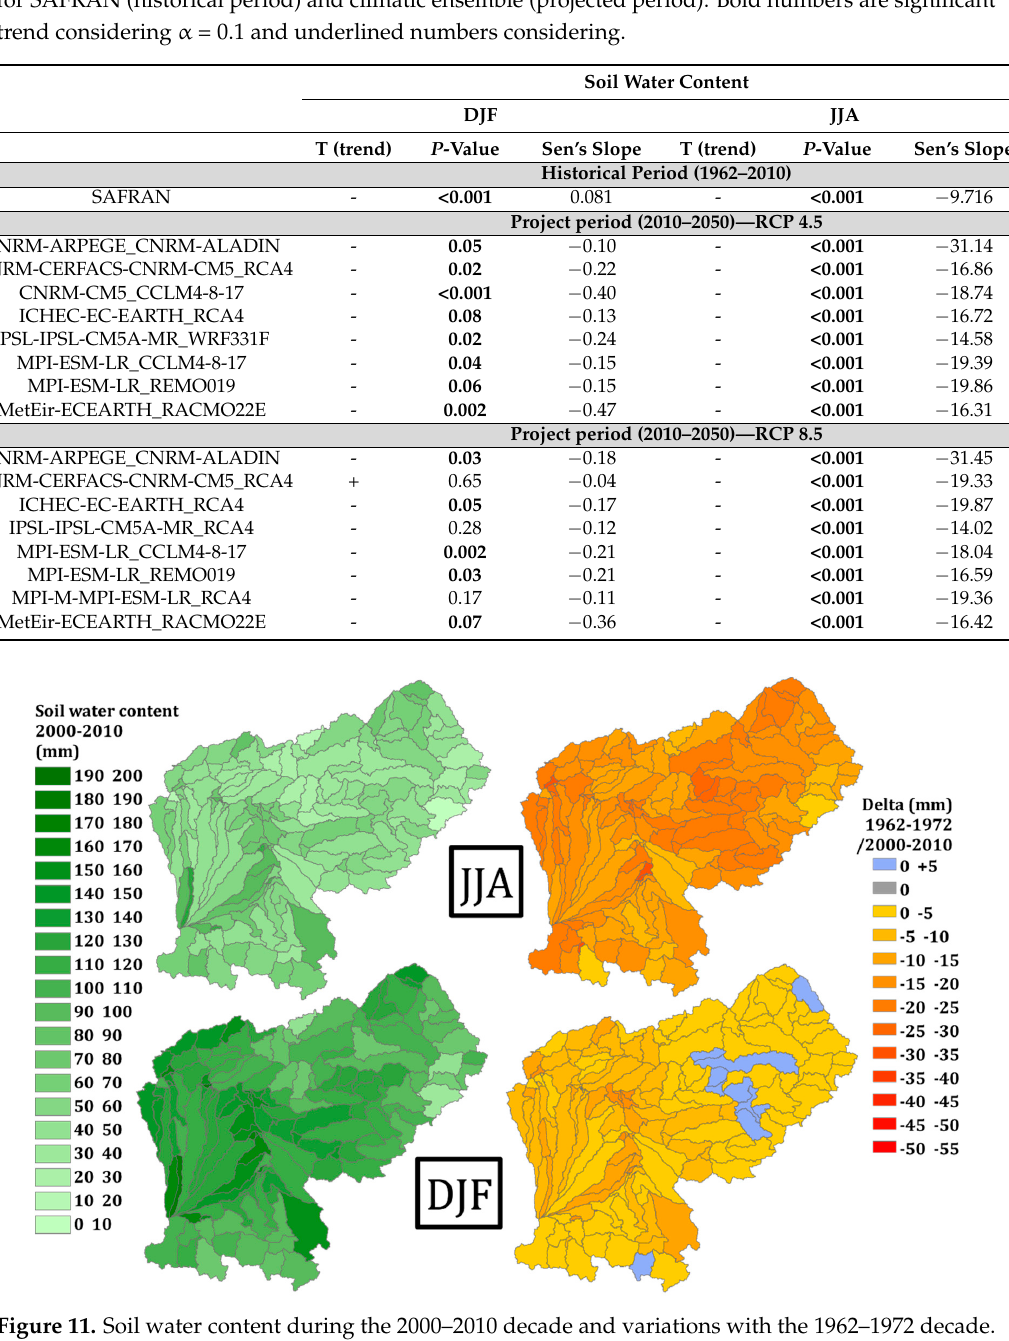
Table 12. Trend in evapotranspiration over winter (DJF) and summer (JJA) seasons at watershed scale, for SAFRAN (historical period) and climatic ensemble (projected period). Bold numbers are significant trend considering α = 0.1 and underlined numbers considering α = 0.05. Evapotranspiration DJF